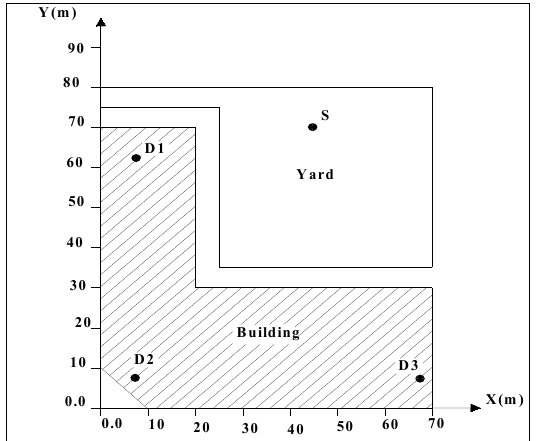
Fig. 5. Layout of site.